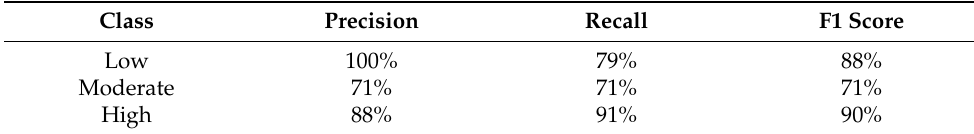
Table A5. Evaluation metrics for each class of the classification